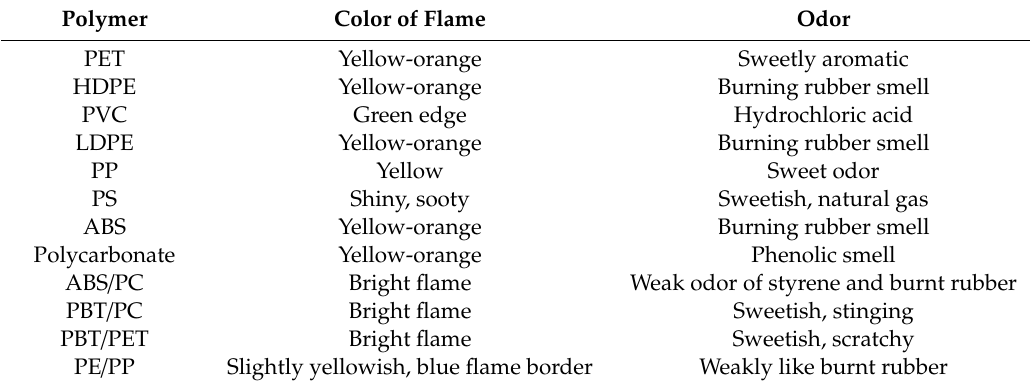
Table 2. Burn test characters of some polymers used in WEEE [85,87].